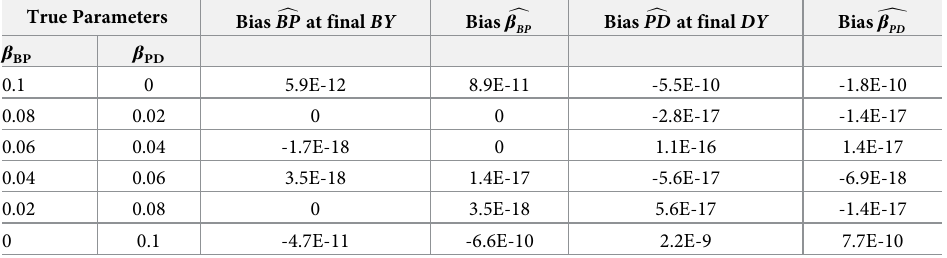
Table 1. Simulation results of parameter optimization using real-valued proportions with no sampling. True Parameters Bias c BP at final BY